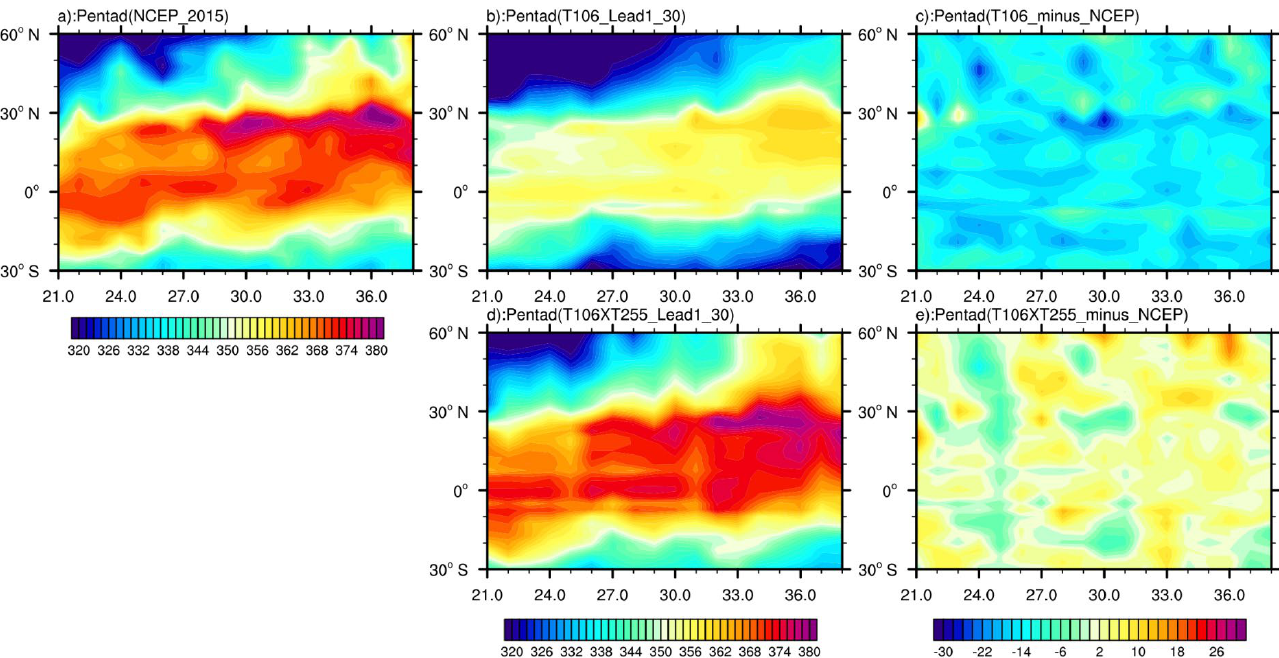
Figure 8. Latitude − pentad cross − section of 850 hPa mean θ se (2015) along 110° − 120° E. The shaded area denotes θ se values (unit: K). ( a ) : reanalysis; ( b , d ): prediction; ( c , e ): difference between prediction and reanalysis.